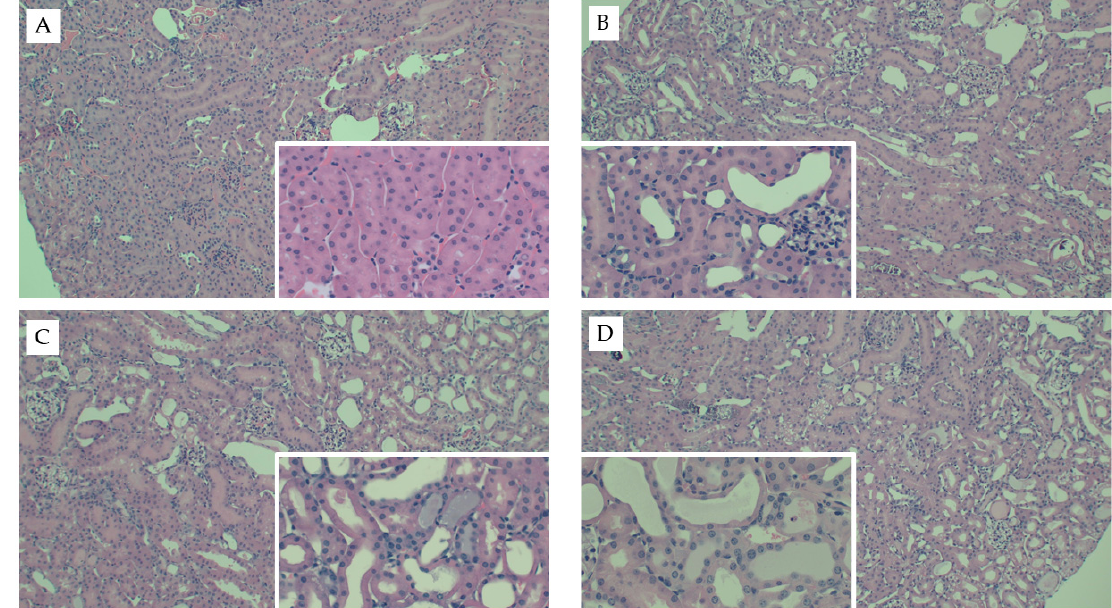
Figure 1. Representative kidney histology images from the FAN study. Representative H&E-stained kidney tissue images from mice fed chow and ( A ) 0.3 mM bicarbonate vehicle control, ( B ) folic acid injection (6.25 mg/500 µL, IP), ( C ) mice fed WD and administered folic acid (6.25 mg/500 µL, IP), or ( D ) mice fed AD and administered folic acid (6.25 mg/500 µL, IP). Larger images were captured at 10× magnification and inset images were captured at 40×.